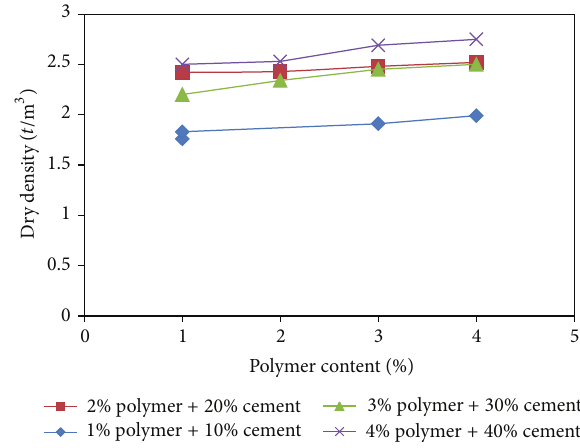
Figure 10: Effect of polymer content on maximum dry density of soil in dry conditions for 15 days.